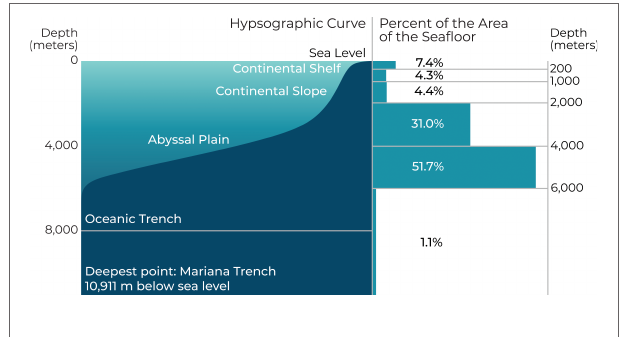
6,000 mbsl (Eakins & Sharman,